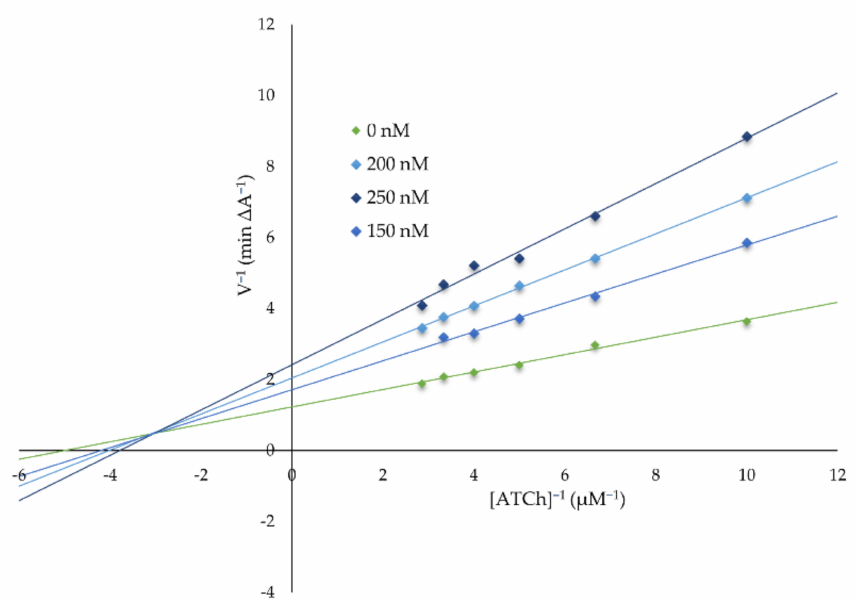
Figure 2. A Lineweaver-Burk plot presenting a mixed-type of BuChE inhibition by 3b